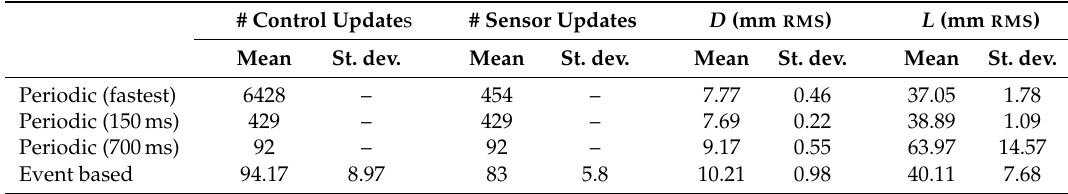
Table 1. Comparison of estimation and control performance between the time-driven and event-driven implementations. Four cases of study and five runs per